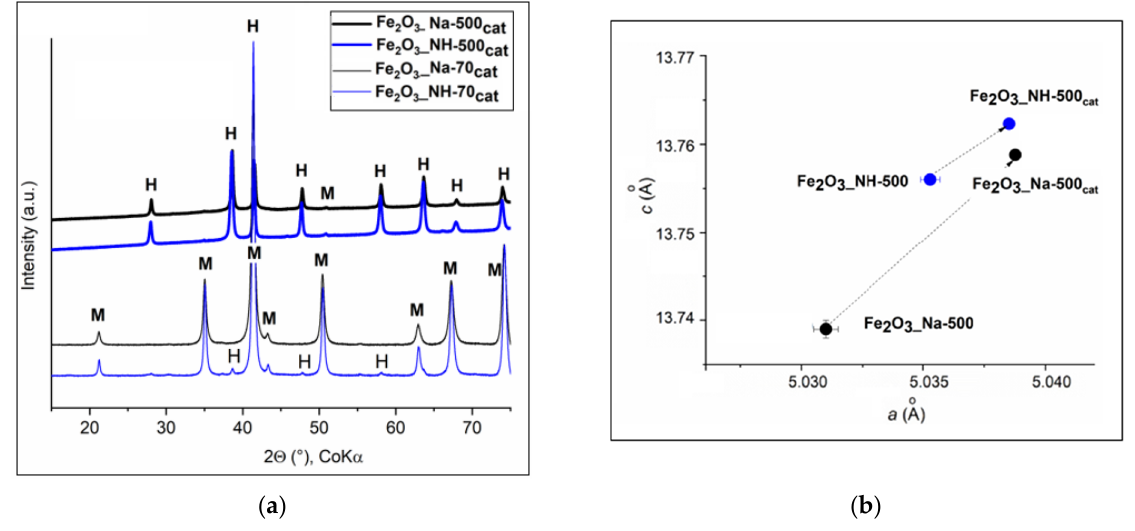
Figure 12. Hydrohematite samples after 2 h of the methane catalytic oxidation test: ( a ) XRD patterns with the peaks denoted as: H = Fe 2 O 3 and M = Fe 3 O 4 ; ( b ) The lattice parameters a, c of Fe 2 O 3 _Na ‐ 500 and Fe 2 O 3 _NH ‐ 500 catalysts were expanded in Fe 2 O 3 _Na ‐ 500 cat and Fe 2 O 3 _NH ‐ 500 cat . After the catalytic test, goethite in Fe 2 O 3 _Na ‐ 70 and protohematite in Fe 2 O 3 _NH ‐ 70 were reduced by CH 4 in Fe 2 O 3 _Na ‐ 70 cat and Fe 2 O 3 _NH ‐ 70 cat (Figure 12a) to the magnetite (PDF No. 01 ‐ 080 ‐ 7683) according to (Equation (5)). After 2 h of catalytic experiment, the highest CH 4 conversion 45.7% to CO 2 and H 2 O took place on the S BET of Fe 2 O 3 _NH ‐ 70 larger about 53 m 2 /g in comparison with Fe 2 O 3 _Na ‐ 70 (Table 1). The calcined Fe 2 O 3 _Na ‐ 500 and Fe 2 O 3 _NH ‐ 500 samples preserved hydrohematite and magnetite in Fe 2 O 3 _Na ‐ 500 cat and Fe 2 O 3 _NH ‐ 500 cat (Figure 12a). The CH 4 conversion